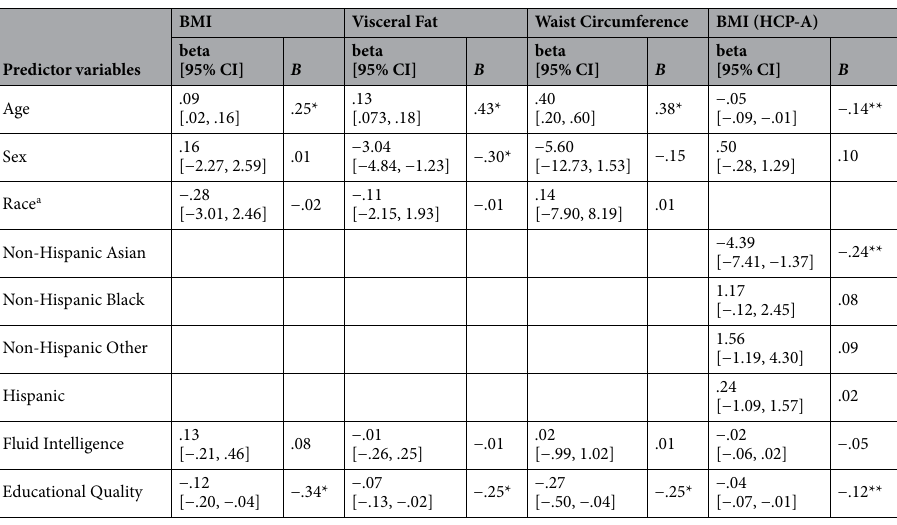
Table 5. Regression models of educational quality predicting BMI, visceral fat, and central adiposity controlling for fluid intelligence. Fluid intelligence was assessed using the Raven’s Progressive Matrices task. * p < .05; a Race was coded as Non-Hispanic White vs.